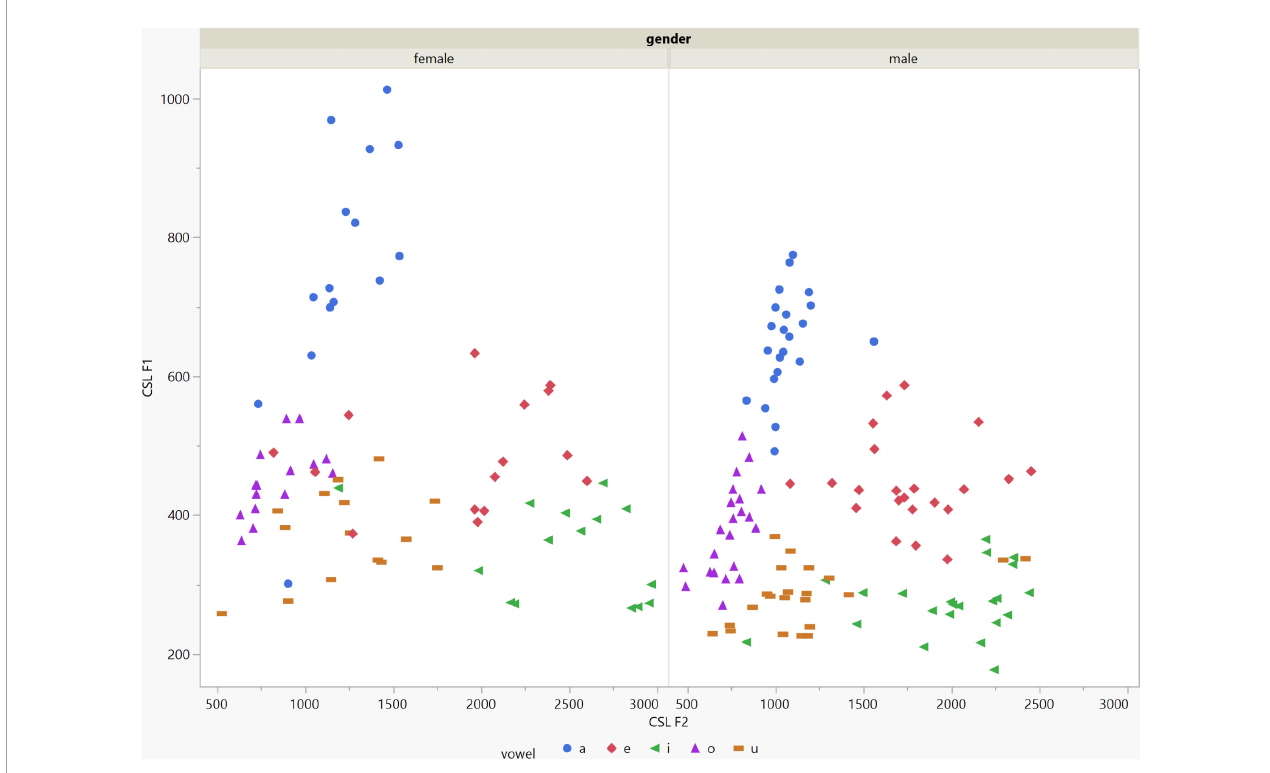
FIGURE2 Arrangement of the F1 and F2 data of the five vowels calculated using Computerized Speech Lab (CSL) for both male and female patients. The data for females showed more scatter along the F1 and F2 axes compared with the data for males specially for the /a/, /i/, /e/ vowels.